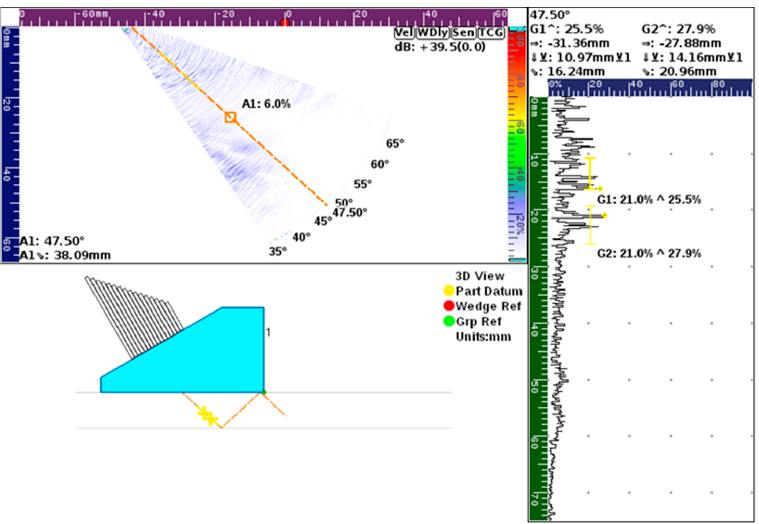
Figure 17. Return signal indistinguishable from background noise detected using PAUT.